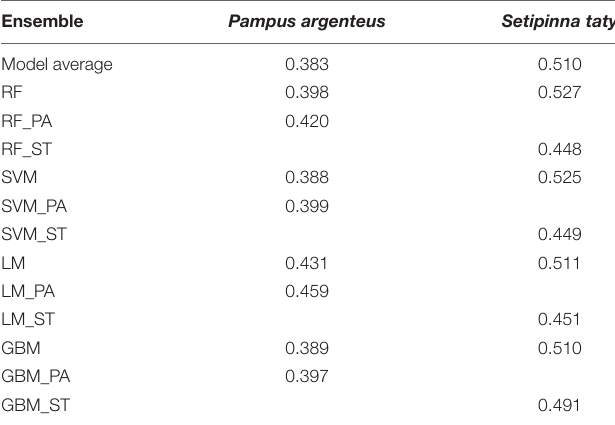
TABLE 3 | The SPR from ensemble models for P. argenteus and S. taty in the Bohai Sea in 2019.